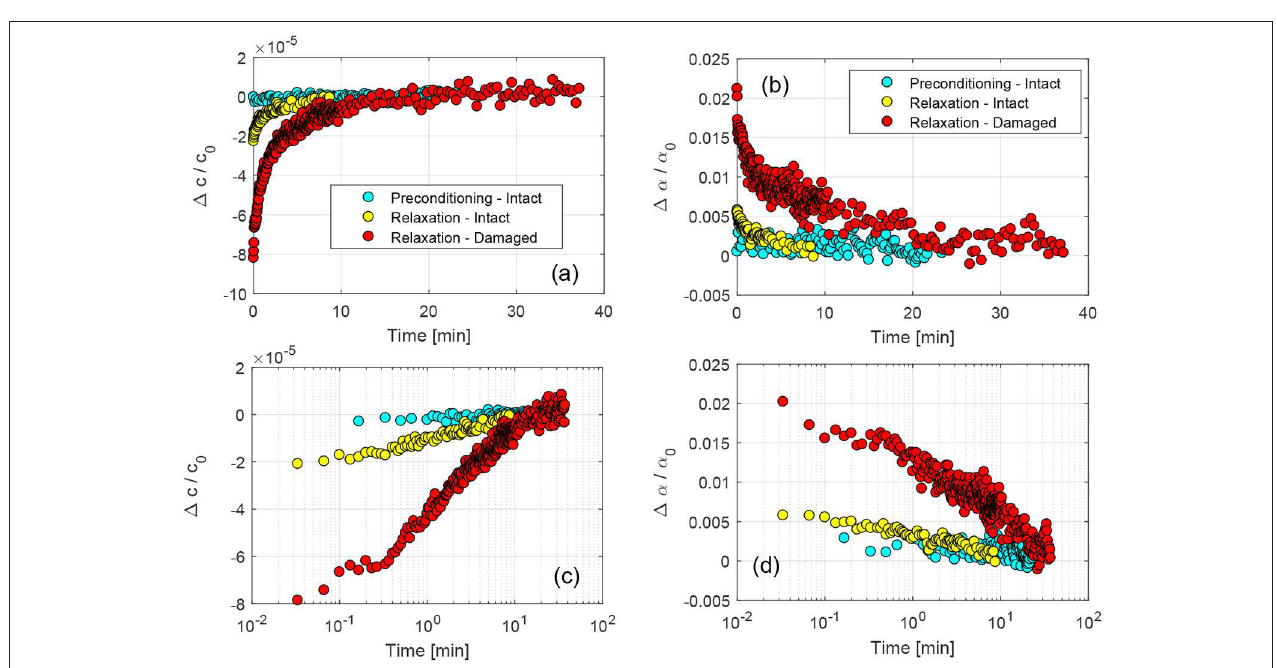
FIGURE 9 | (a,b) Comparison of the temporal evolution of velocity and damping as a function of time between intact and damaged samples. In (c,d) a semilog plot is shown.